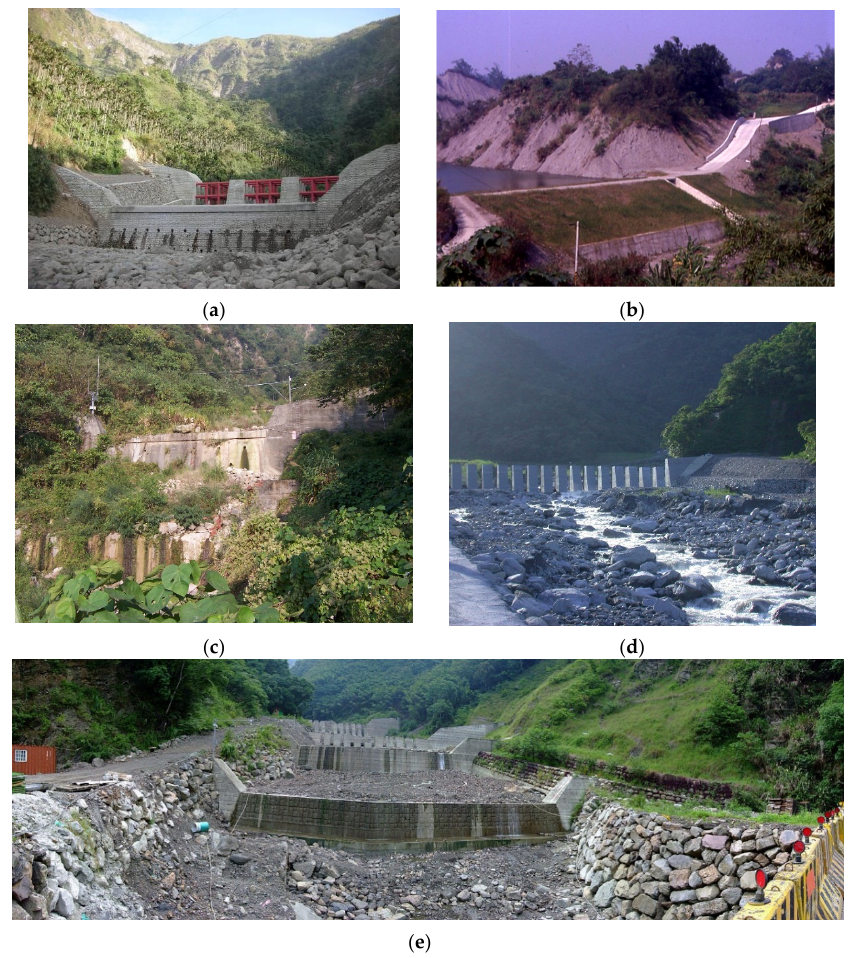
Figure 6. Photos of check dams: ( a ) case 1; ( b ) case 2; ( c ) case 3; ( d ) case 4; ( e ) case 5. Table 6. Results of Scenic Beauty Assessment on a check dam.